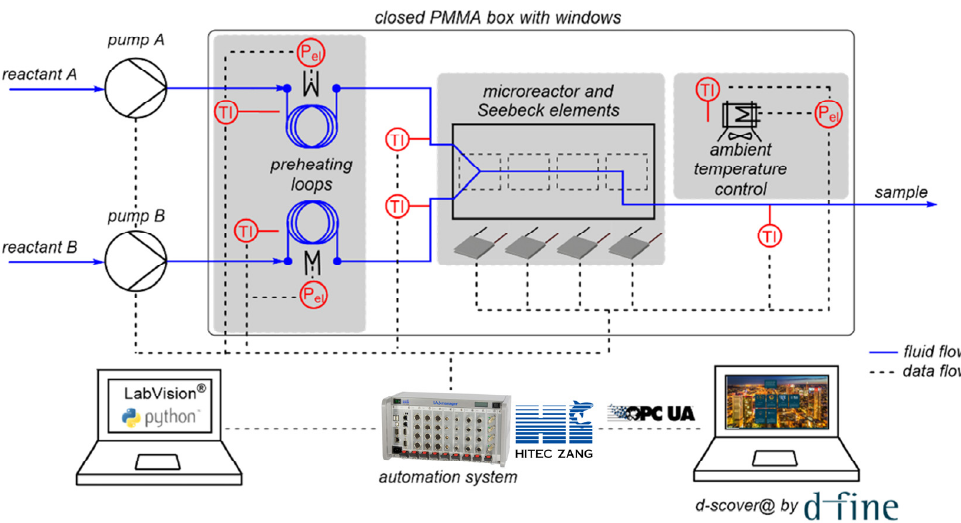
Figure 3. Complete experimental setup used for calorimetric measurements including data